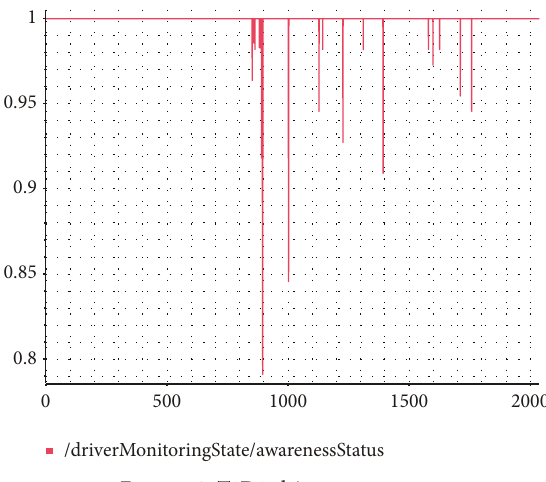
Figure 4: T1D1 driver awareness.